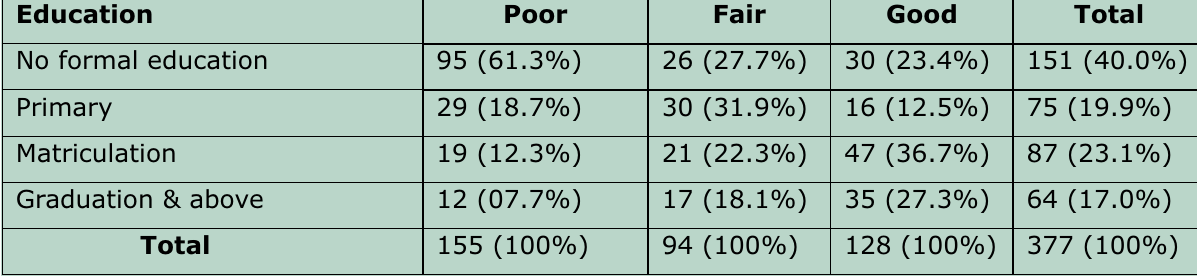
Table-II: Educational level of respondents and use of antenatal services. Education